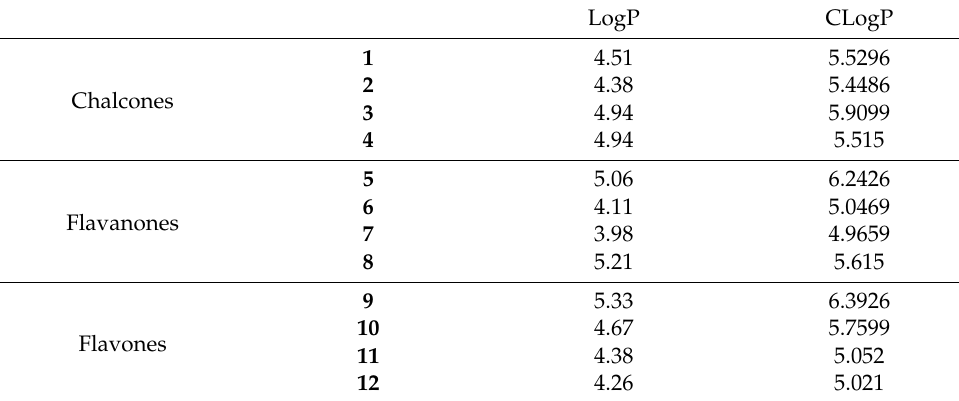
Table 4. The lipophilicity (CLogP) of the tested